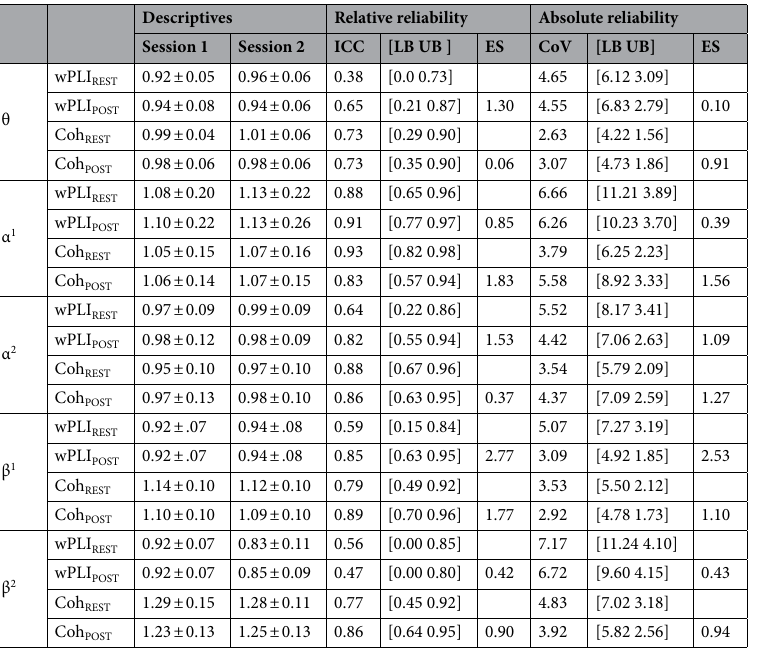
Table 3. Overview of results revealed from reliability analysis for small-world-index values before and after 10 min of running on the treadmill. Data are presented as outcome means ± standard deviations. For purposes of reliability, table provides Intraclass-Correlation-Coefficients (ICC) as well as Coefficient of Variation (CoV) including lower (LB) and upper bound (UB) of the 95% confidence interval of two sessions performed within one week. Effect size estimations (ES) are based on bootstrap analysis with k = 100 cycles running the bootes function (Di Plinio